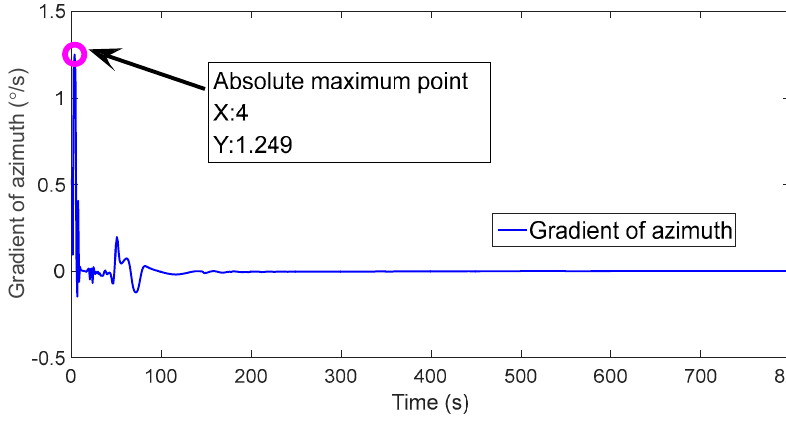
Figure 4. The gradient values of azimuth angle error.